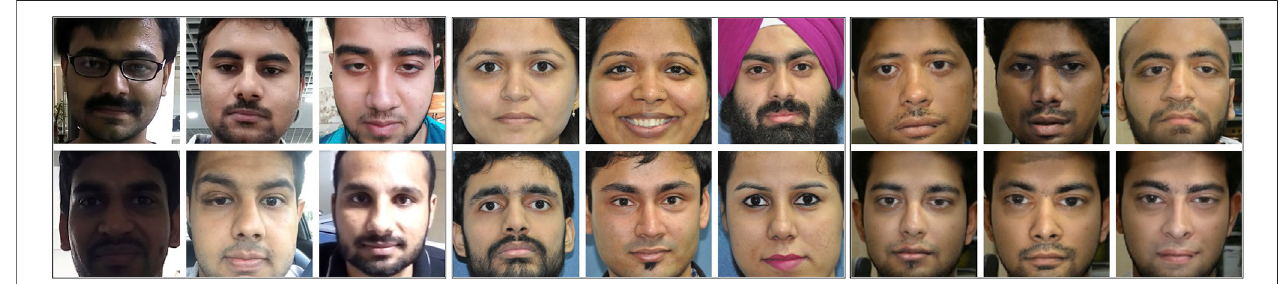
FIGURE5| SampleimagesfromtheproposedSnapchatfaceswapdatabase. (A) Samplebona fi deimagesset (left3columns) , (B) sampleimagesusedforface swap (middle 3 columns) , and (C) morphed images from Snapchat (right 3 columns)